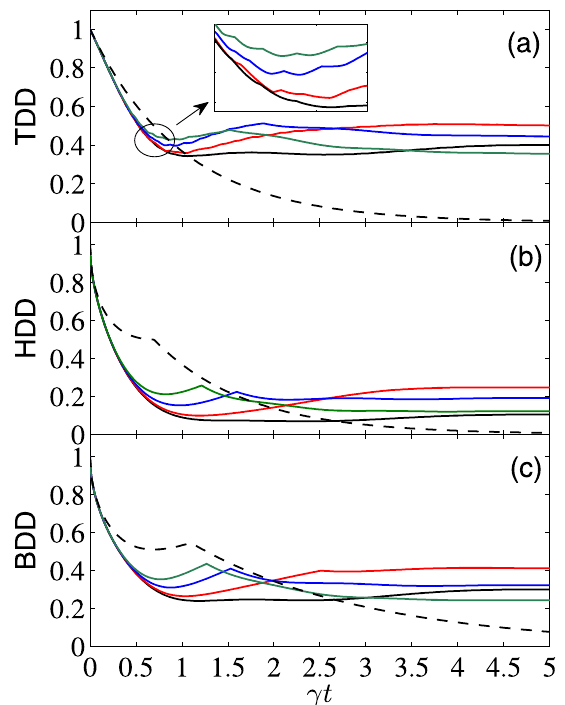
Figure 3. γ t dependence of TDD, HDD, and BDD (in units of J ) for the initial state ψ + , with = n 0 , Δ = 1, and B = 0 (black solid), 0.8 (red solid), 1.6 (blue solid), and 2.4 (green solid). Moreover, the dashed curve shows the case of noninteracting